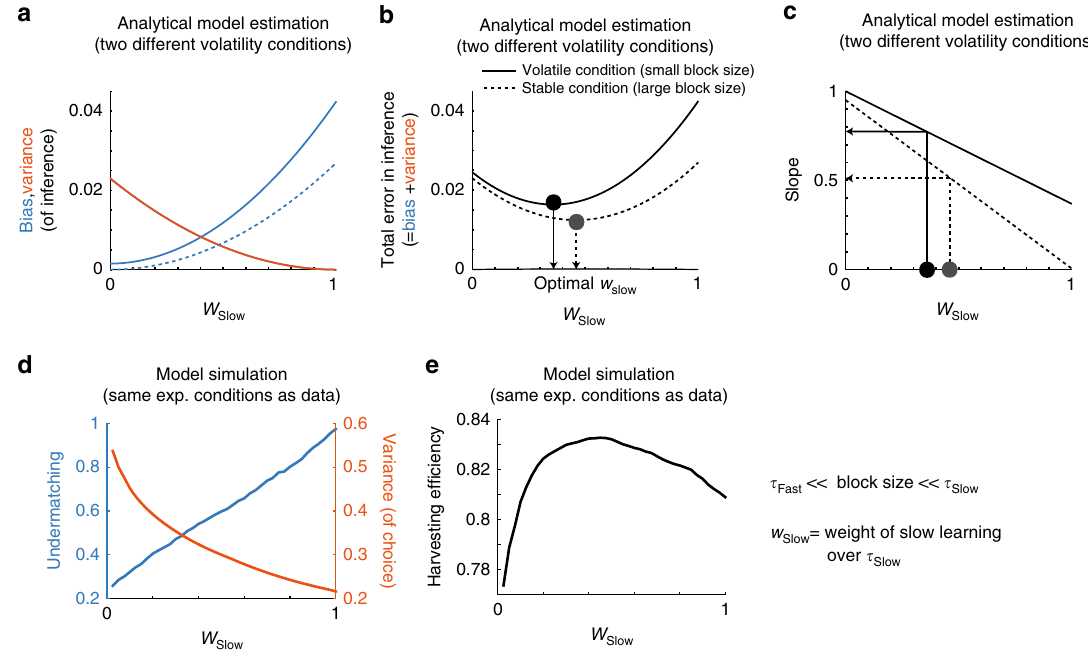
Fig. 3 Model analysis: the bias-variance trade-off and the optimal choice behavior under uncertainty. a – c Analytical model results for two different volatility conditions, with a block size of 100 trials (more volatile) or 10,000 trials (less volatile). All the solid (dashed) lines refer to the results for a less (more) volatile task with a block size of 100 (10,000 trials). a Bias (blue) and variance (orange) of model ’ s inference about reward rates show a tradeoff as a function of the relative weight of the slow integrator ( w Slow ). The bias is squared. b The squared error of model ’ s inference about reward rates, which is the sum of the squared bias (blue in a ) and the variance (orange in a ), is plotted against w Slow for different volatility conditions. The optimal relative weight w Slow for the volatile environment (solid vertical line) is smaller than that for the stable environment (dotted vertical line), since more volatile environments (solid curve) require faster integrators, or a smaller relative weight of the slow integrator. c Deviation from the matching law (shown as the slope of block- wise choice fraction vs reward fraction) covaries with the relative weight of the slow integrator, and also with the volatility condition. d , e Model simulation results on the same experimental schedule experienced by monkeys. d Model simulations show a clear tradeoff between undermatching (a form of behavioral bias) and the variance of choice probability, as a function of the relative weight of slower learning w Slow . The square root of variance is shown for illustration. e Model simulations also show changes in harvesting ef fi ciency as a function of the relative weight of the slow integrator w Slow . As a result of the bias-variance trade-off, the curve takes an inverted U-shape, with a maximum at the optimal relative weight, determined by the volatility of the experiment. For panel d , we computed the variance of Monkey ’ s choice probability as follows. First, monkey ’ s choice time series was smoothed via two half-gaussian kernels with standard deviations of σ = 8 trials and σ = 50 trials, with a span of 200 trials. This gave us two time series: a fast one with σ = 8 trials and a slow one with σ = 50 trials. We de fi ned the variance as the variance of the fast one over the slow one. The squared root of variance is shown in the panel. For panels d , e models with different w Slow ’ s were simulated on the experimental schedules experienced by Monkey F. We set τ Fast = 2, τ Slow = 1000 trials. Note that our results do not rely on the precise choice of τ Fast and τ Slow (see also Fig.